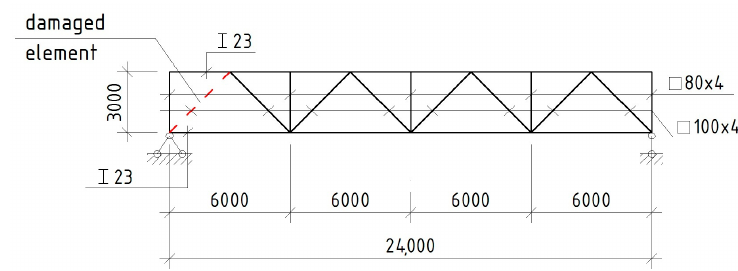
Figure 15. Truss with a damaged support brace.